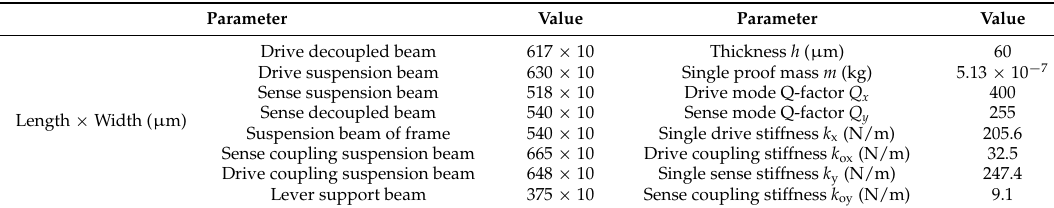
Table 1. Simulation parameters.